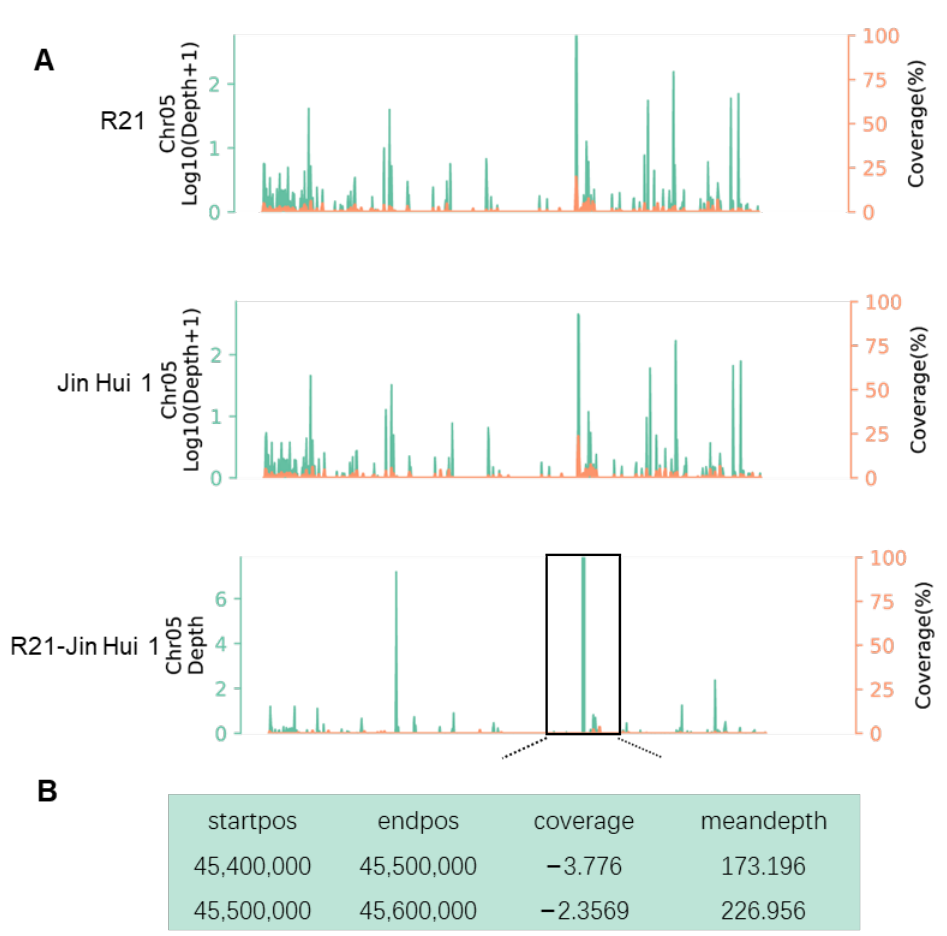
Figure 2. Identification of insertions/homologous fragments in sorghum. ( A ) Distribution of depth of coverage of chromosome 5 between R21 and Jin Hui 1; ( B ) Region of significant difference in depth of coverage between R21 and Jin Hui 1 (top 1%). Green represents depth, Orange represents coverage.